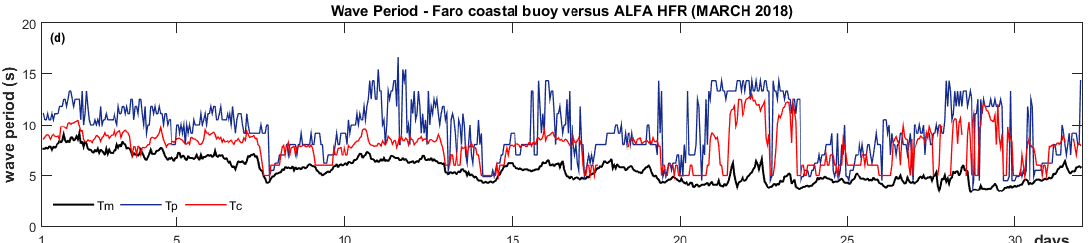
Figure 9. Wave period time series for March 2018. ( a ) PRIO / Baves buoy; ( b ) VILA / Villano-Sisargas buoy; ( c ) SILL / Silleiro and ( d ) ALFA / Faro coastal buoy. Black: mean wave period (Tm) from buoy; blue: peak period (Tp) from buoy and red: centroid period (Tc) from HFR.